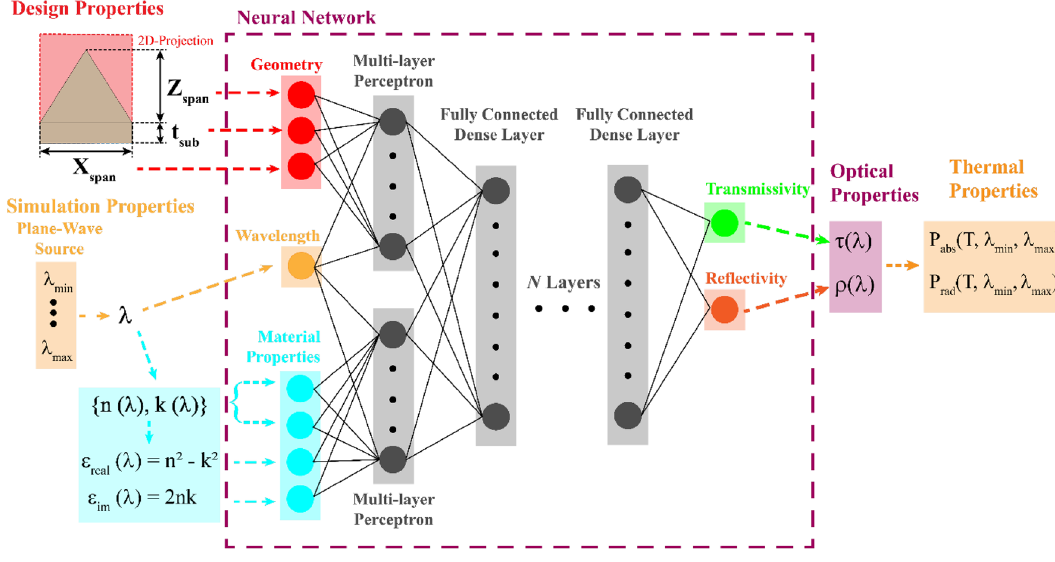
Figure 1. Visualization of Deep-Neural Network (DNN) construction and and overall process